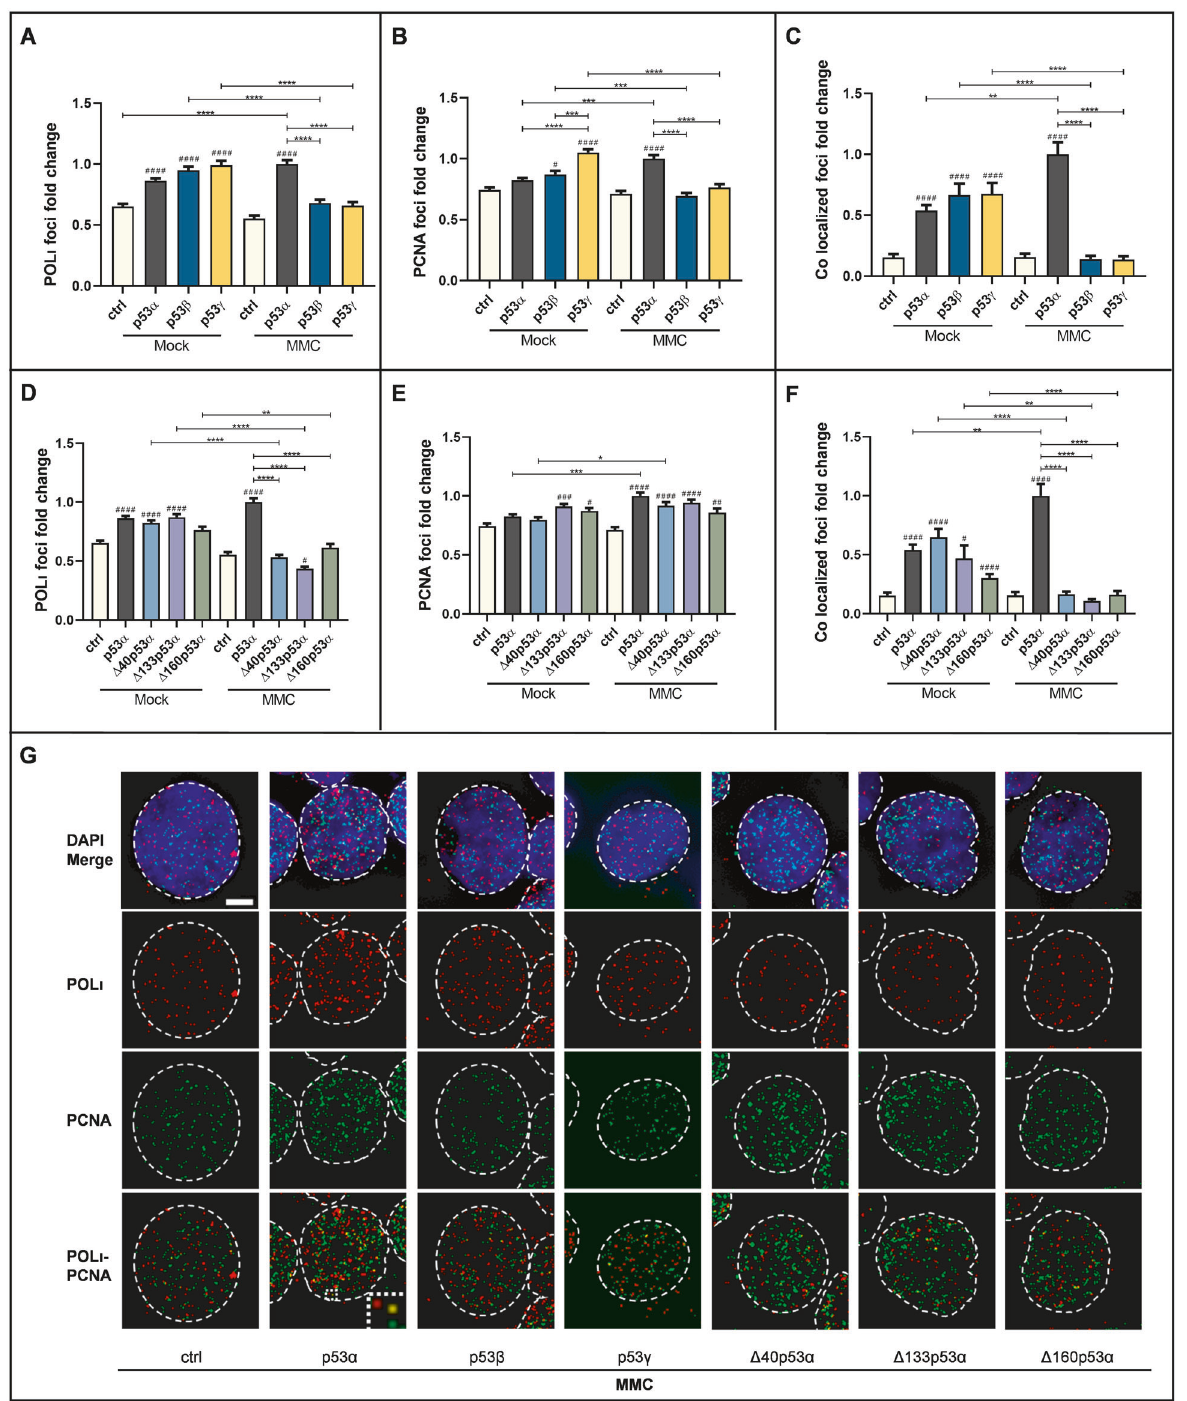
Fig. 3 Effect of the p53 isoforms on the subcellular distribution and association of POL ι and PCNA. K562 cells were transfected with expression plasmids for p53 α , alternative p53 isoforms [ A − C p53 β , p53 γ , D − F Δ 40p53 α , Δ 133p53 α , Δ 160p53 α ] or EV in controls (ctrl). Forty- eight hours after transfection, cells were mock- or MMC-treated (3 μ M, 45 min, 3 h release) and processed for immunostaining to visualize POL ι and PCNA foci as well as their co-localization. At least 100 nuclei were scored in ≥ two independent experiments. Mean values for p53 α expressing cells after MMC-treatment were set to 1 [on average 103 POL ι ( A , D ), 133 PCNA ( B , E ), and 15 POL ι -PCNA co-localized ( C , F ) foci/ nucleus]. For graphic presentation, calculation of SEM and statistically signi fi cant differences via Dunn ’ s multiple comparisons test GraphPadPrism8.4 software was used. Representative images of MMC-treated samples are shown in ( G ). The experiments shown in ( A ) and ( D ), ( B ) and ( E ) as well as ( C ) and ( F ) were performed together (values of ctrl and p53 α are identical but separated in different panels for clarity) and with the experiments presented in Fig. 6. *(#) P < 0.05, **(# #) P < 0.01, ***(# # #) P < 0.001, ****(# # # #), P < 0.0001 (scale bar: 5